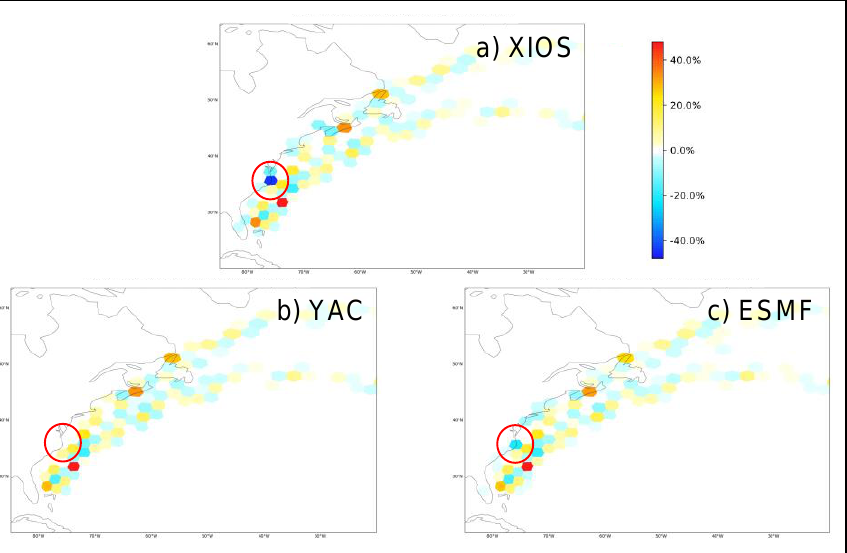
Figure 17. Misfit in the gulf stream region for the second-order conservative remapping of the gulfstream function for torc-icos for XIOS, YAC and ESMF. The red circles identify the grid point near the coast showing an outstanding value for XIOS.